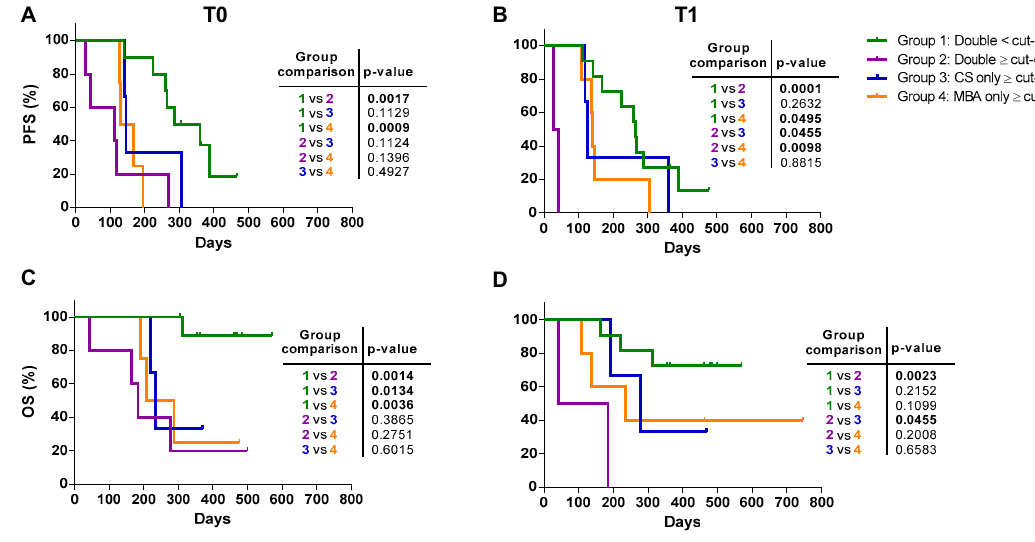
Figure 5. Progression-free survival (PFS) and overall survival (OS) of mBC patients stratified by the combination of the metabolic-based assay (MBA) and CellSearch (CS) method. The patients were stratified into four group: group 1 (green curve), patients with a CTC count below the cut-off with both methods; group 2 (violet curve), patients with a CTC count ≥ cut-off with both methods; group 3 (blue curve), patients with a CTC count ≥ cut-off only for the CS; and group 4 (yellow curve), patients with CTC count ≥ cut-off only for the MBA. ( A ) PFS of mBC patients stratified by the combination of the two methods at baseline (T0) and ( B ) follow-up (T1). ( C ) OS of mBC patients stratified by the combination of the two methods at baseline (T0) and ( D ) follow-up (T1). Statistical analysis of PFS and OS between the four groups are reported in the embedded tables. Table 5. PFS and OS according to the combined application of the metabolism-based assay (MBA) and CellSearch (CS).